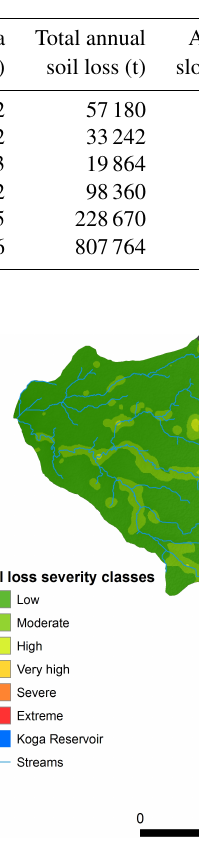
Figure 8. Spatial distribution of soil loss severity classes of the study